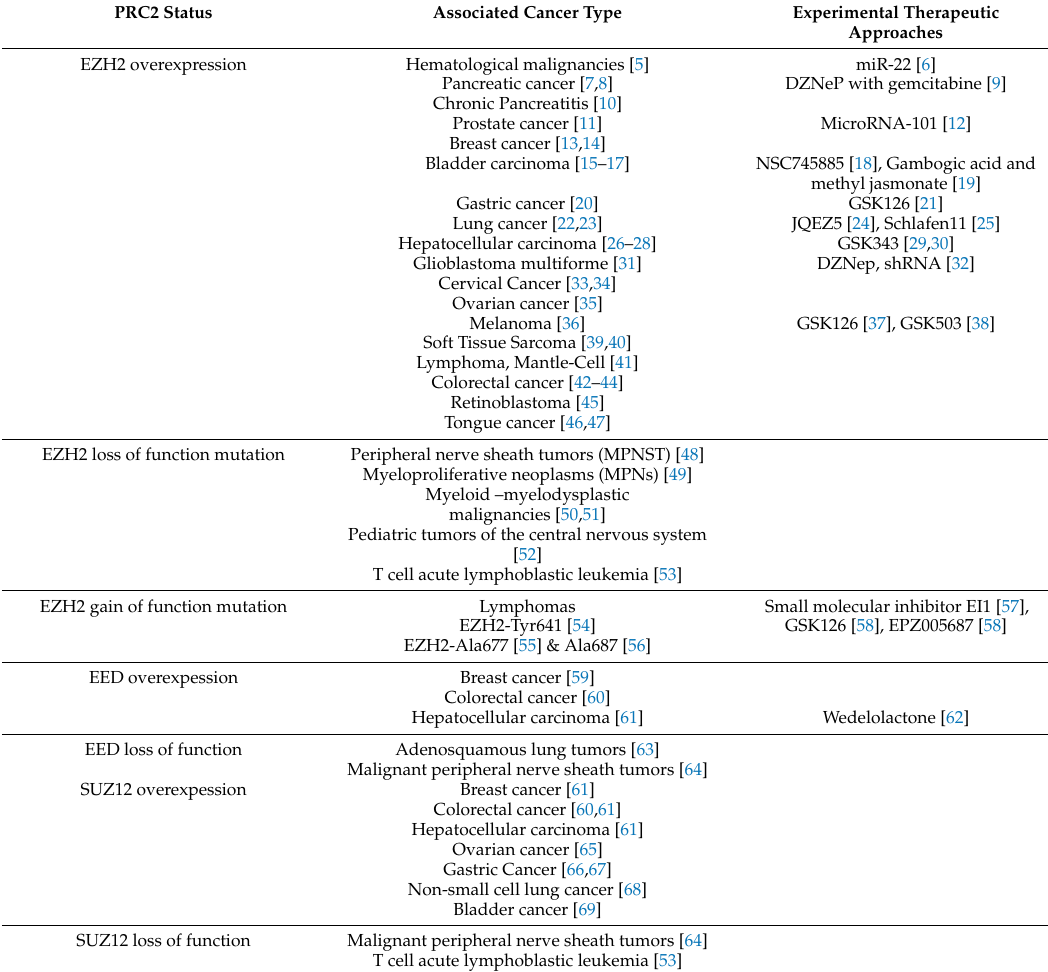
Table 1. Polycomb repressor complex 2 status in